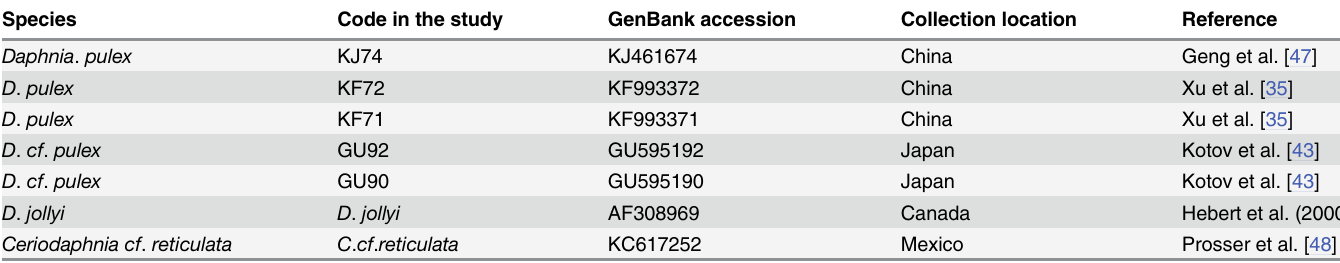
Table 3. CO I gene sequences of Daphnia and Ceriodaphnia from